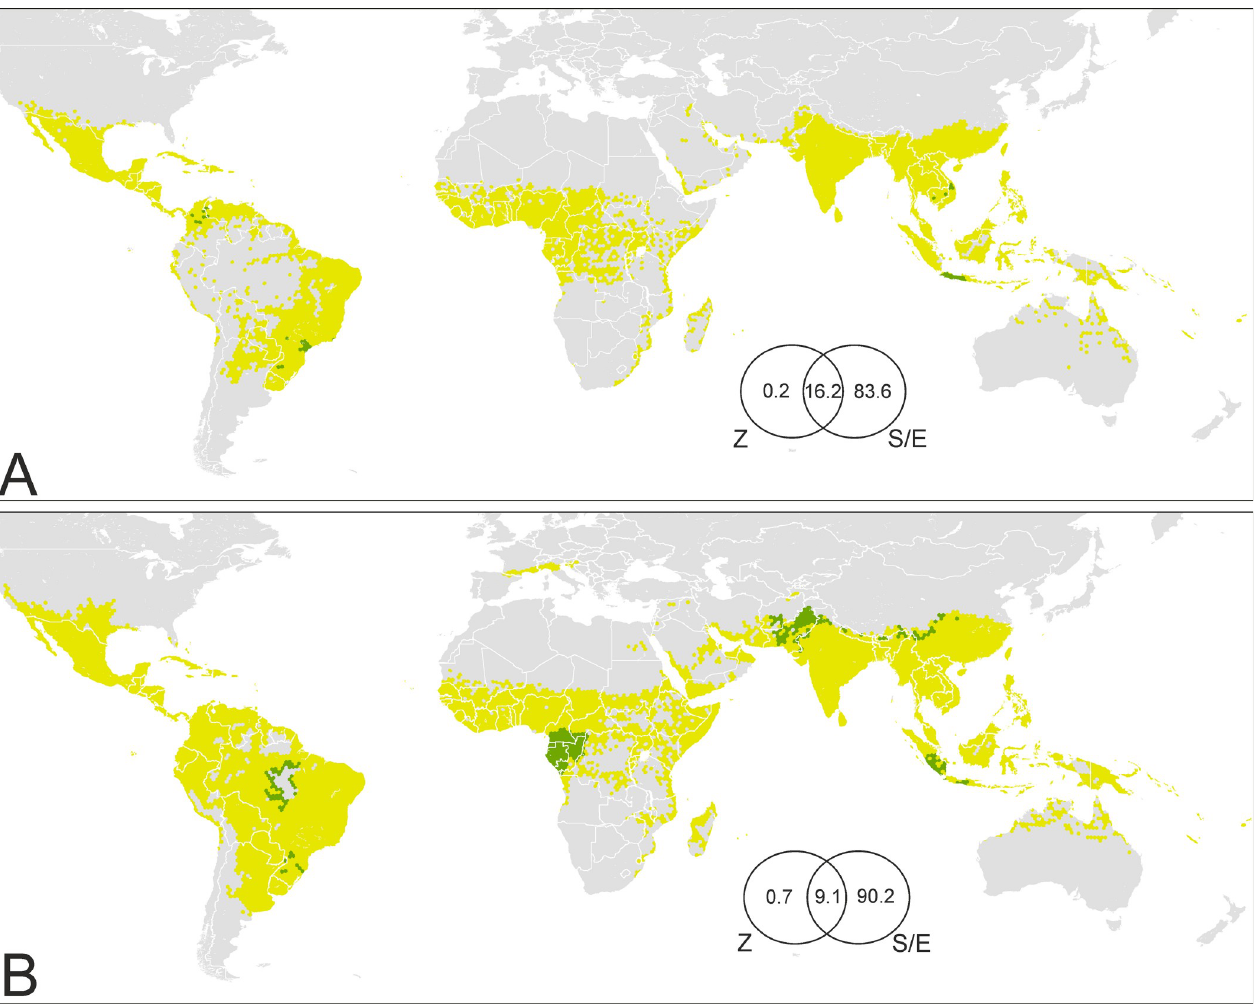
Fig 4. Areas of potential influence of sylvatic cycles on the presence of dengue in humans. (A) Late 20 th century; (B) early 21 st century. Green: > 0.1 increase of favorability values attributed to primate chorotypes; yellow: � 0.1 increase of favorability values attributed to primate chorotypes; grey: area with low risk of dengue transmission. Venn diagrams: The numbers are percentages of contribution to the distribution of favorability in the disease models (Z: Zoogeographic factor; S/E: Spatial/Environmental factor). Coast lines source: